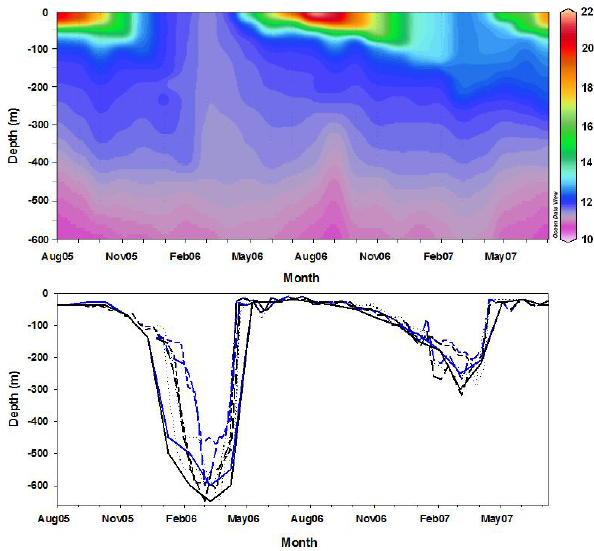
Fig. 5. Argo float 6900362 temperature data for the Bay of Bis- cay for the period between August 2005 and July 2007 in the upper 600m (top panel), and mixed layer depths (MLD) calculated from the Argo floats 4900557 (short dashed line), 6900359 (dotted line), 6900360 (long dashed line) and 6900362 (solid line) data (bottom panel) with 1 T (depth-surface) of − 0.5 ◦ C (blue line) and 1σ t (depth-surface) of 0.125 (black line) for the period between August 2005 and July 2007 (http://www.coriolis.eu.org/cdc/argo.htm).